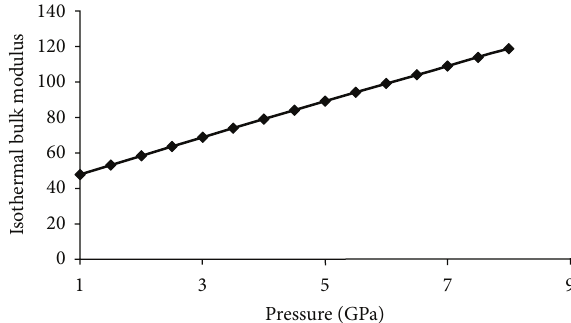
Figure 3: Variation of isothermal bulk modulus ( 𝐵 𝑇 ) with pressure for nanotube